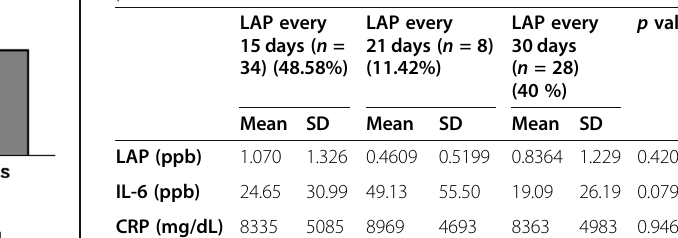
Fig. 10 One-way ANOVA test for LAP between penicillin and regimen groups